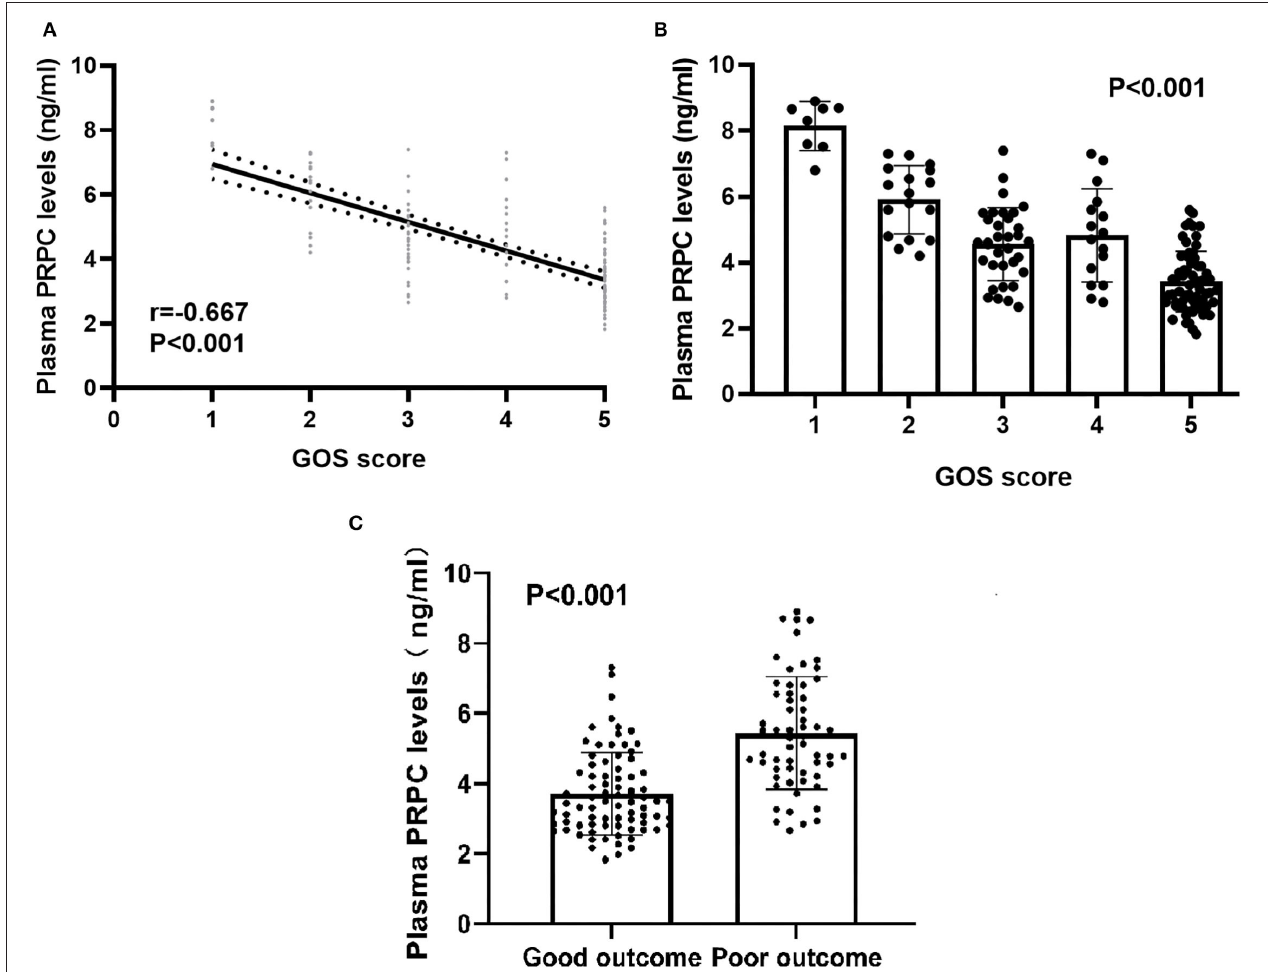
FIGURE 4 | Relationship between plasma cellular prion protein levels and clinical outcome at 90 days after intracerebral hemorrhage. (A) Relationship between plasma cellular prion protein levels and Glasgow Outcome Scale score at 90 days after intracerebral hemorrhage. When the Glasgow Outcome Scale score was a continuous variable, plasma cellular prion protein levels were significantly declined with raised Glasgow Outcome Scale score using Spearman correlation coefficients ( r = − 0.667, P < 0.001). In a correlation graph, the solid line means the line of best fit, and the dashed line represents 95% confidence interval of a population mean. (B) Differences in plasma cellular prion protein levels among patients with Glasgow Outcome Scale score at 90 days after intracerebral hemorrhage. Plasma cellular prion protein levels significantly differed among patients with different Glasgow Outcome Scale scores using Kruskal–Wallis H -test ( P < 0.001). (C) Comparison of plasma cellular prion protein levels between patients with good outcomes and those with poor outcomes at 90 days after intracerebral hemorrhage. Patients with a poor outcome ( n = 59) had substantially higher plasma cellular prion protein levels than those with a good outcome ( n = 79) using Mann–Whitney U -test ( P < 0.001). Abbreviations: GOS, Glasgow Outcome Scale; PRPC, cellular prion